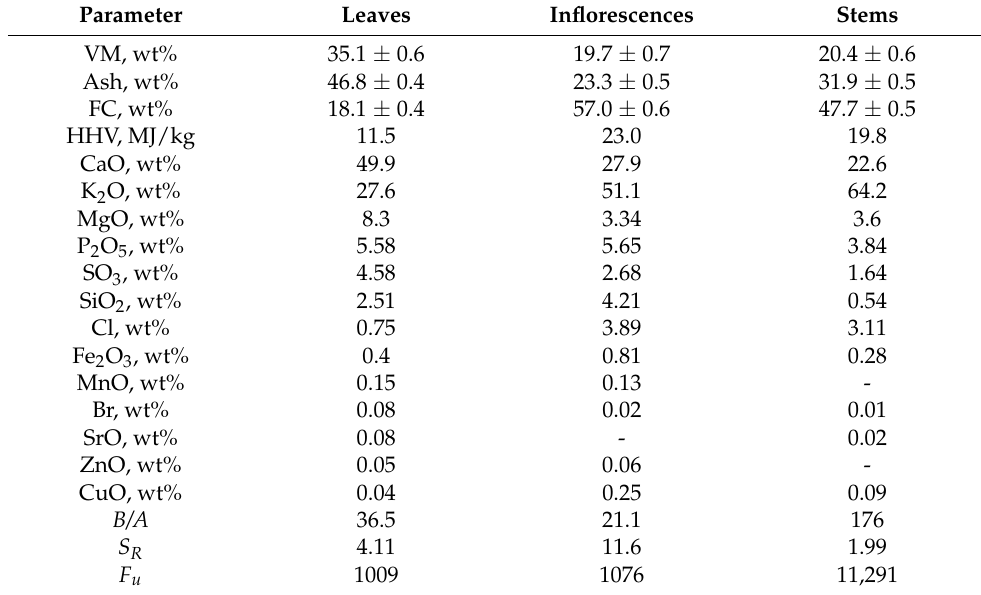
Table 6. Results of the proximate analysis, oxide compositions of biochars, and slagging parameters.